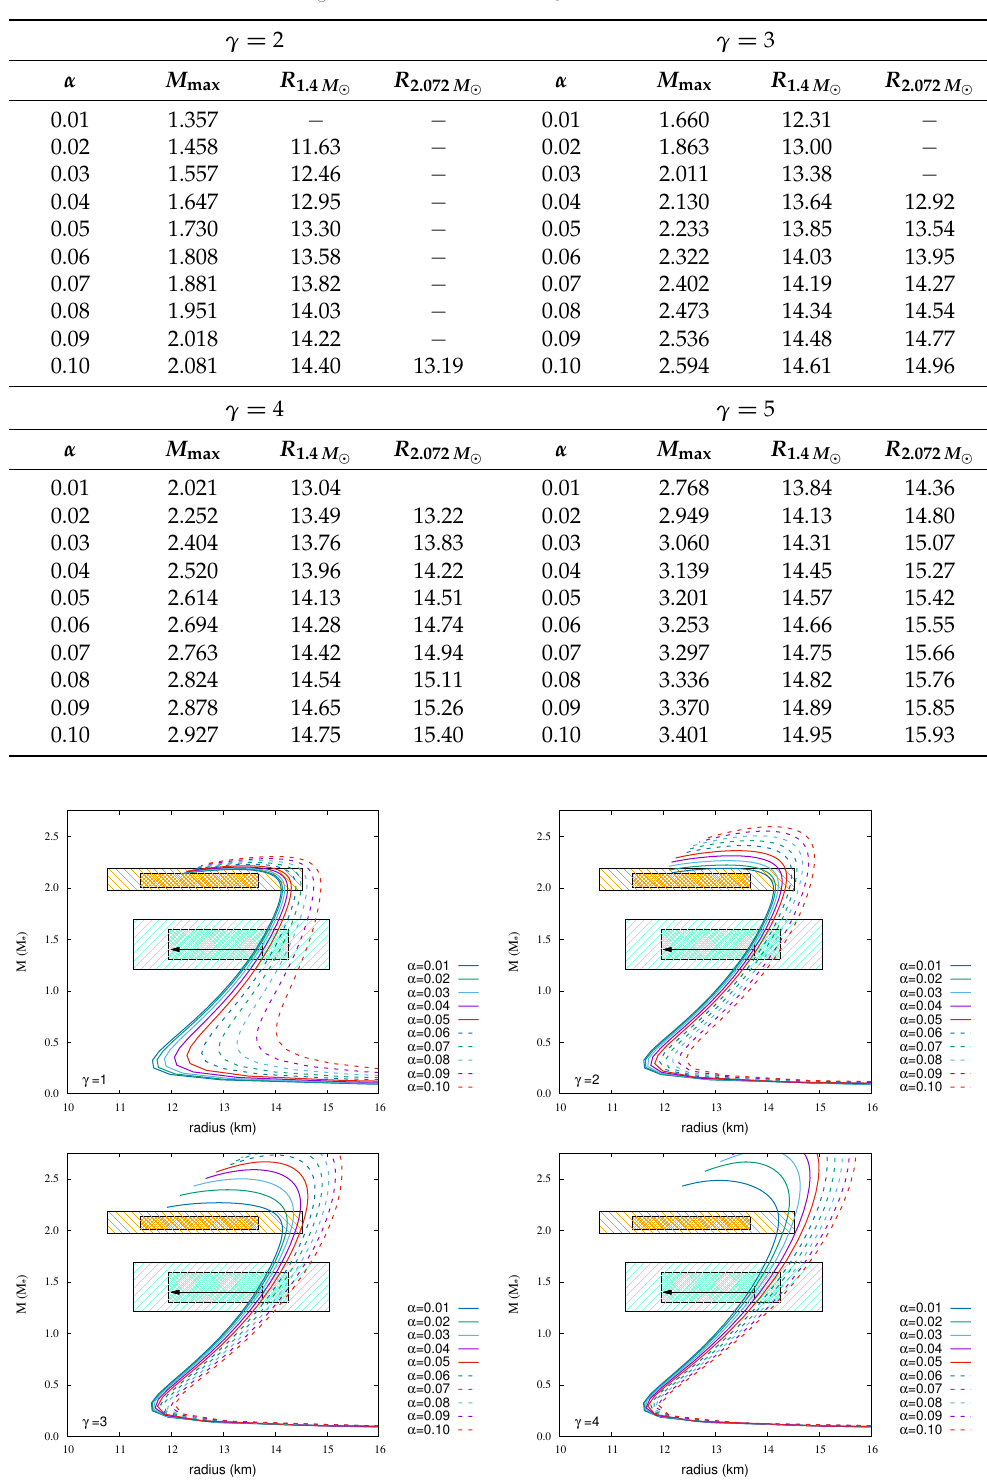
) and radius (cid:12)